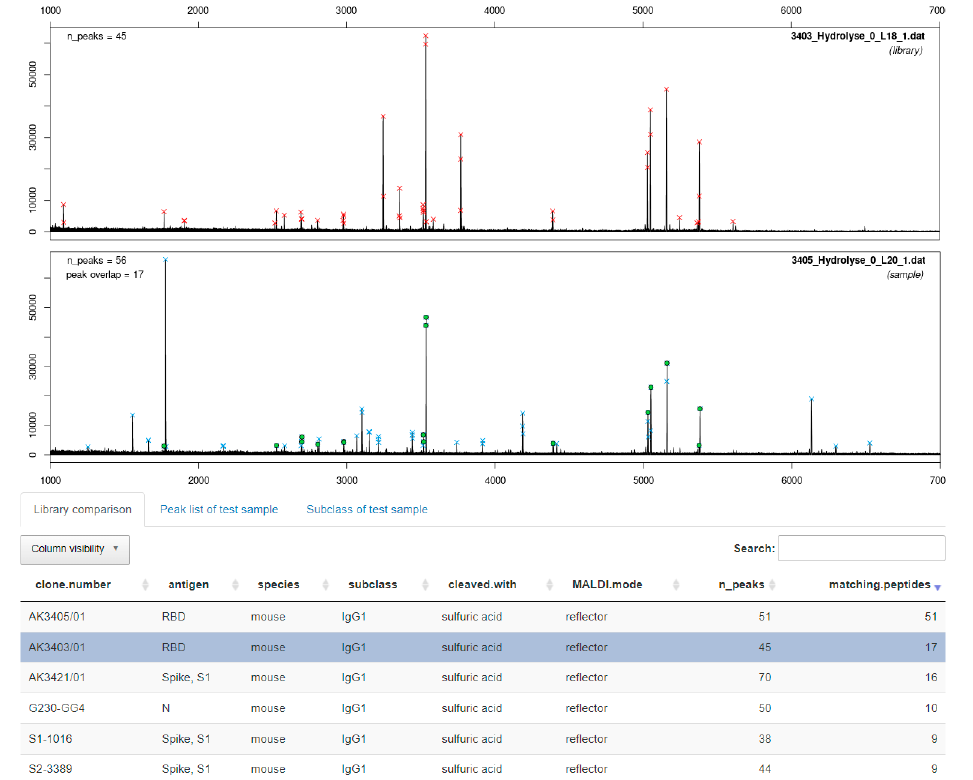
Figure 12. Screenshot of the graphical user interface of the ABID 2.0 software. The antibody 3405 (bottom spectrum, fingerprint with acidic cleavage) is matched against a library of 36 antibodies containing the clone 1016. The same spectra are also compared in Figure 9. The software finds 51 matching peptides (100%) with the library spectrum of the sample spectrum (first row). Seventeen matching peptides are found for clone 3403 (highlighted in blue). However, it also finds a comparable number of peptides with other clones in the library, meaning no clone in this library is identical to 3405.